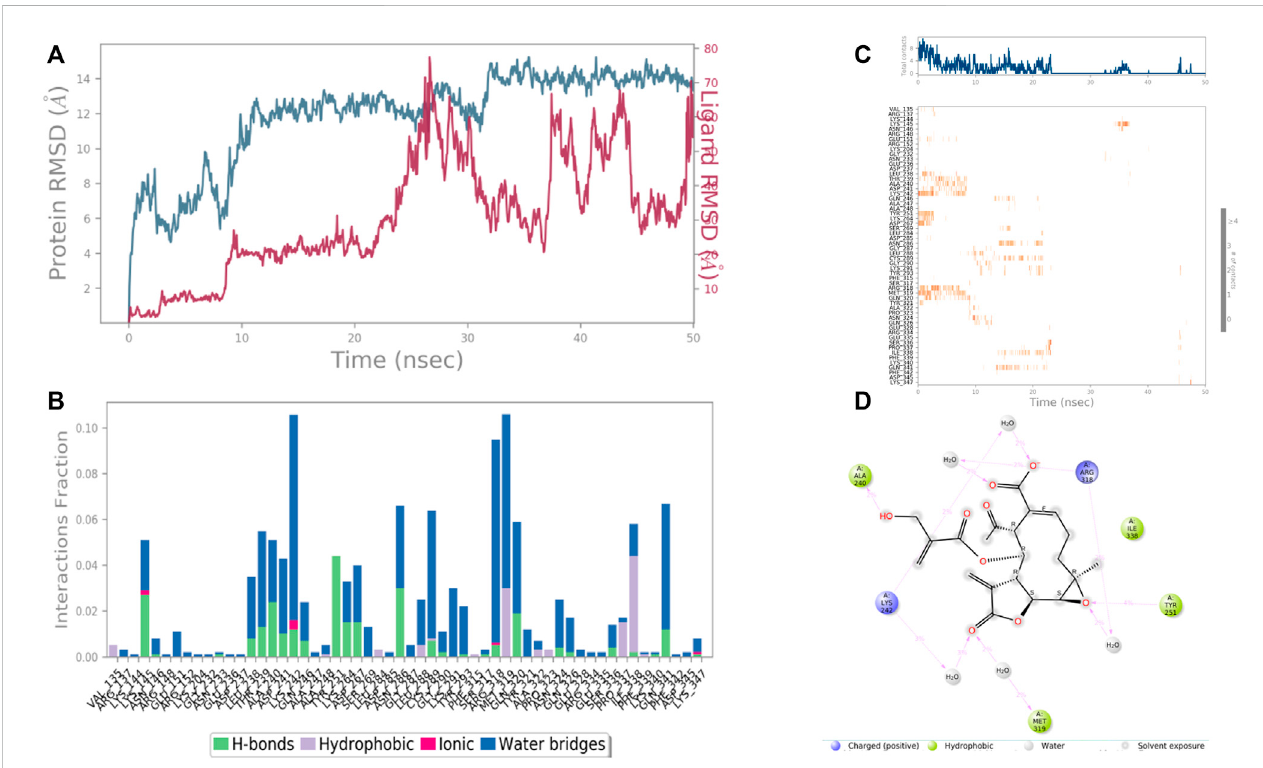
FIGURE 10 RMSDplotoftheprotein-ligandcomplex(PDBID:1J72) (A) Protein-ligandcontacts (B) ,stackedbarplotofthefractionoftimeoftheinteractions (C) and Ligand- Protein contacts (D) of analogue 8-Desacyl enhydrin-[4-hydroxymethacrylate] for 50 ns of simulation